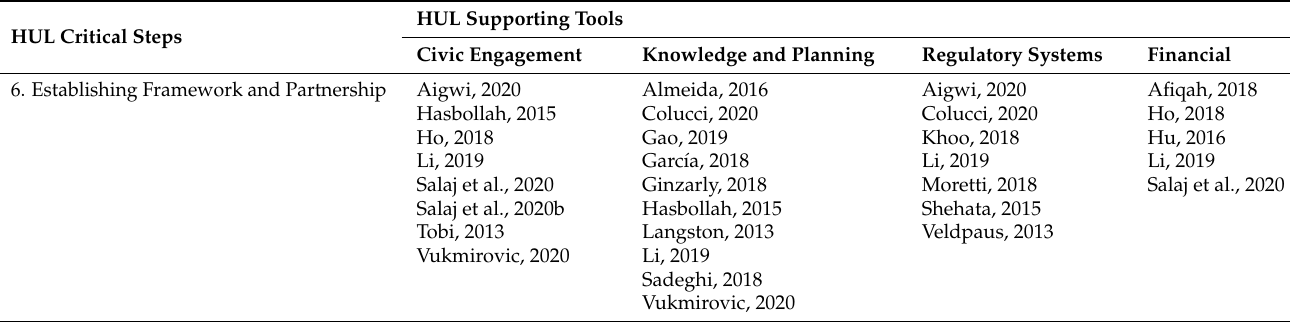
Table 6. List of authors discussing the establishing framework and partnership supporting tools of the HUL approach within the urban heritage facility management